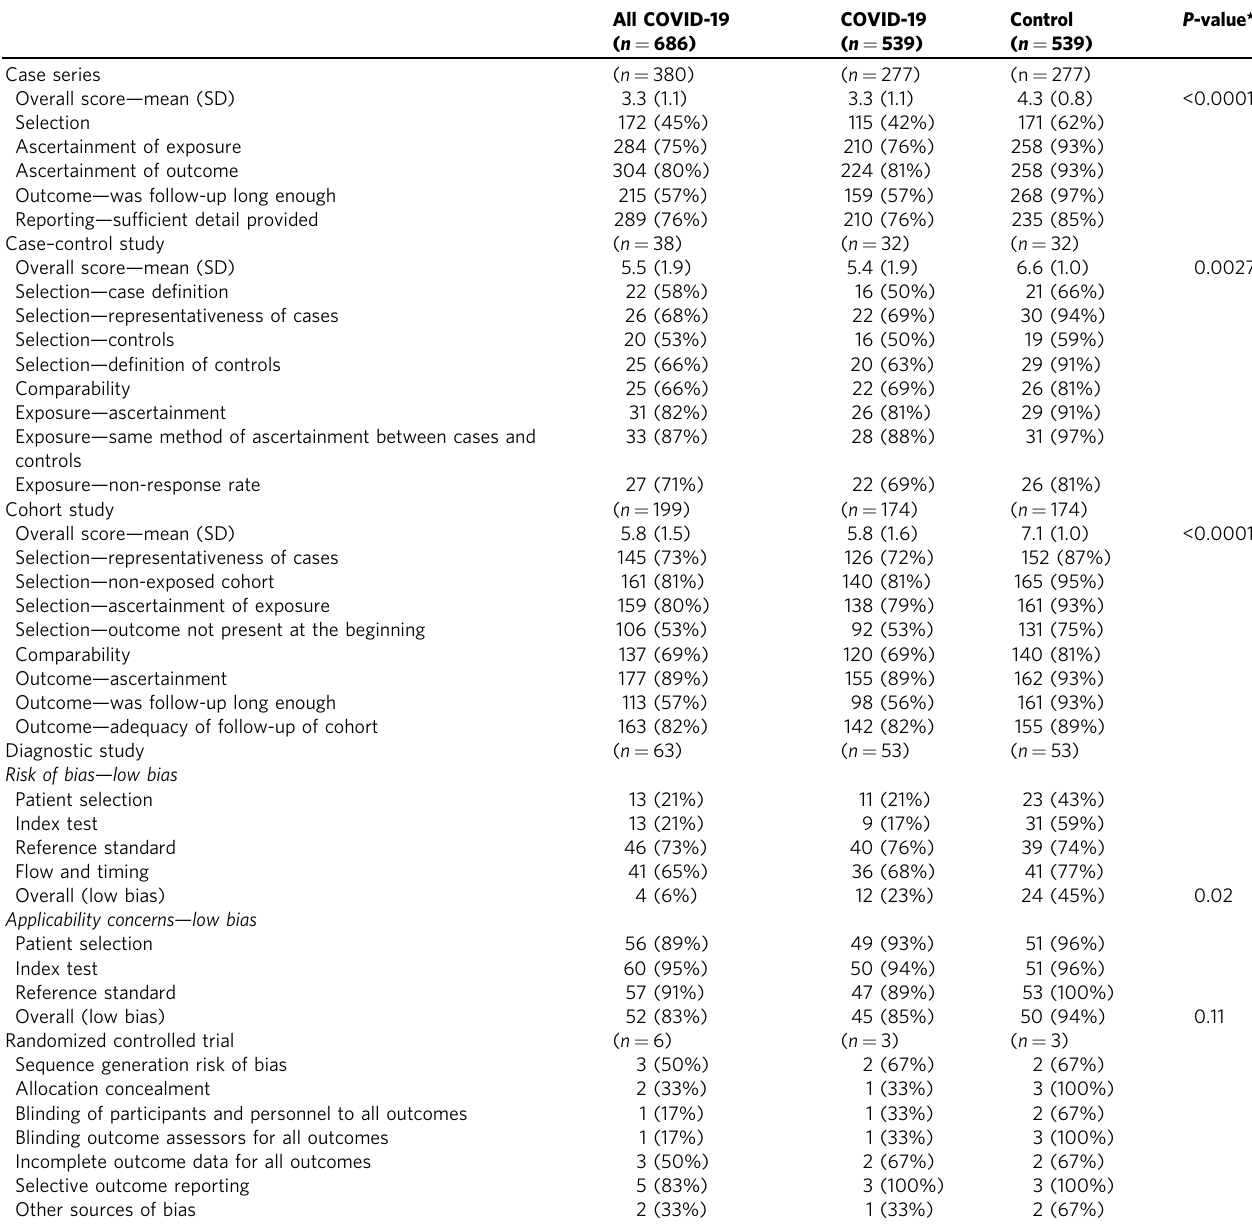
Table 2 Methodological quality scores of different study types strati fi ed by COVID-19 and historical control